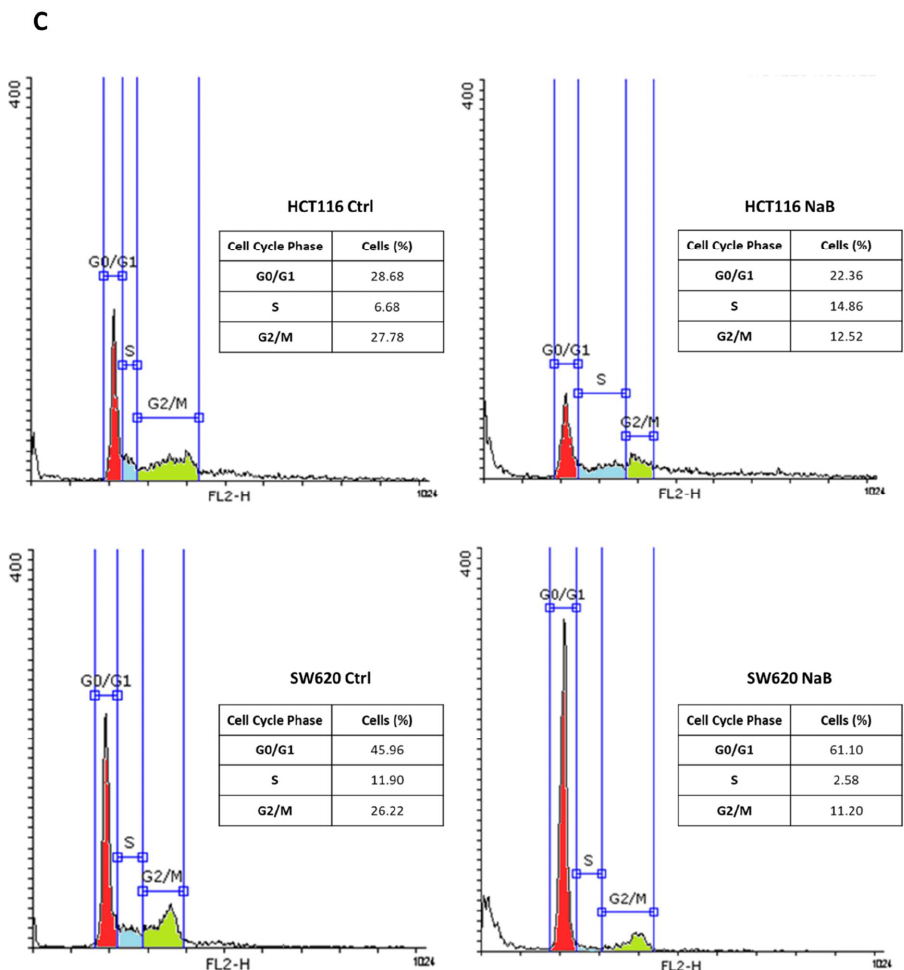
Figure 1. Sodium butyrate (NaB) inhibits colorectal cancer (CRC) cell proliferation. ( A ) HCT116 and SW620 cells were incubated with 2 mM NaB for the indicated time points. Cell counting was performed up to 72-h of treatment. At the end of each experimental time point, the cell suspension was diluted 1:1 with trypan blue and counted. The graph represents the average ± SD calculated in triplicate for each sample (significance was considered as follow: **** p < 0.0001). ( B ) HCT116 and SW620 cells adhering to the coverslip were treated with 2 mM NaB for 48 h. Medium was replaced and NaB re-added at 24 h. At the end of the treatment, coverslips were processed for immunofluorescence staining of Ki67 (green) and p21 (red). Nuclei were stained with DAPI. The cells were photographed under fluorescence microscopy (scale bar = 8.5 μ m, magnification = 63×). ( C ) HCT116 and SW620 cells were incubated with 2 mM NaB for the indicated time. Cytofluorimetric analysis of the cell cycle was performed at 48 h using a FacScan flow cytometer. The area under each peak shows a different fraction of cell population in the respective cell cycle phase. Cell cycle analysis was performed in triplicate for each experimental condition. A representative analysis out of three for each condition, with reproducible data, is shown.